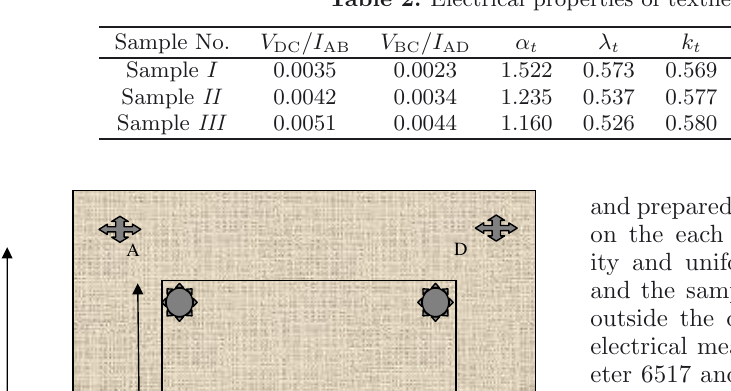
Table 2. Electrical properties of textile samples.